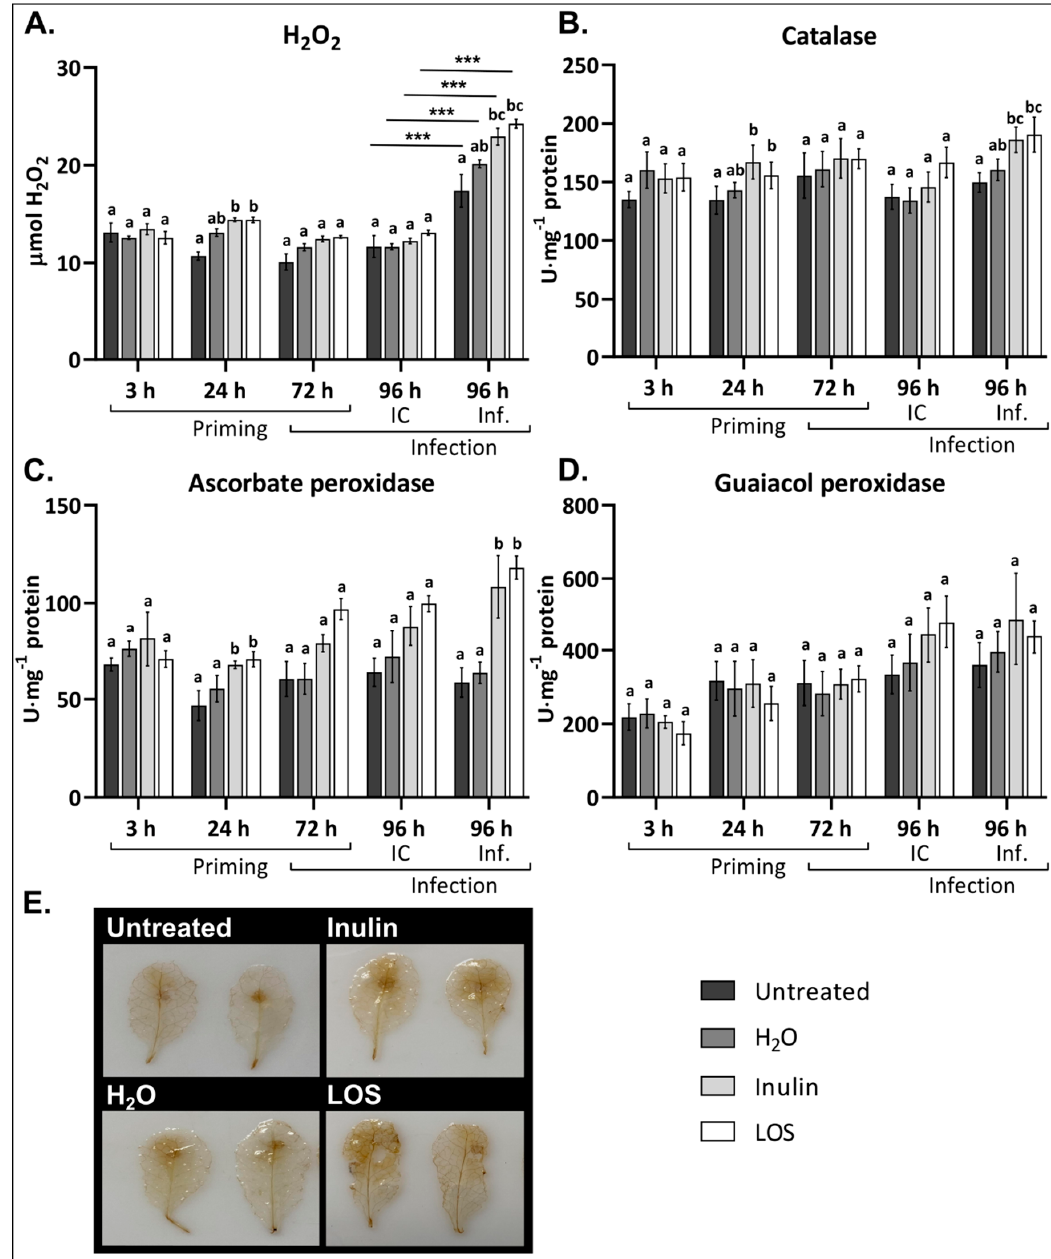
Figure 6. Effect of fructan treatment on H 2 O 2 content and H 2 O 2 scavenging enzymes in the leaves after treatment and B. cinerea infection. Arabidopsis plants treated with 5 g/L inulin or LOS followed by B. cinerea infection 72 h later were analyzed for ( A ) H 2 O 2 content, ( B ) catalase activity, ( C ) ascorbate peroxidase activity and ( D ) guaiacol peroxidase activity. Bars represent the mean ± SE of 6 biological replicates. Statistical significance is indicated by different letters (a–c) within the same timepoint ( p < 0.05) with asterisks (*** p < 0.001) between time points and is based on two-way ANOVA, followed by Tukey’s multiple comparison test and adjusted p values. Experiments were repeated three times with consistent results. ( E ) Representative leaves analyzed for H 2 O 2 distribution by DAB staining 24 h after infection.